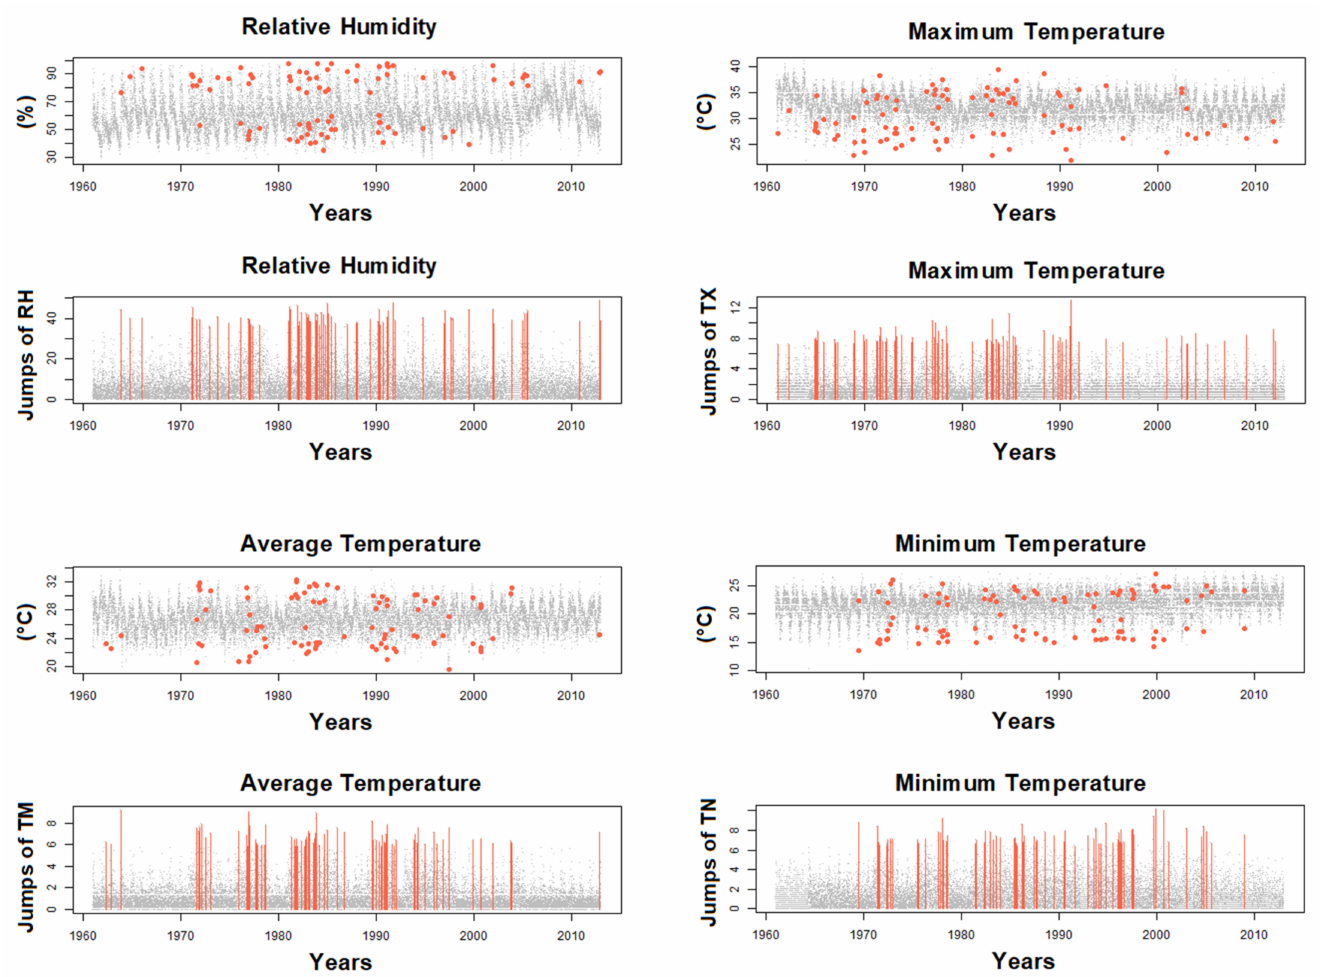
Figure 12. Results of the moving limits test for the 1% and 99% percentiles for relative humidity, and maximum, average and minimum temperatures. Red dots indicate values that exceeded these thresholds.